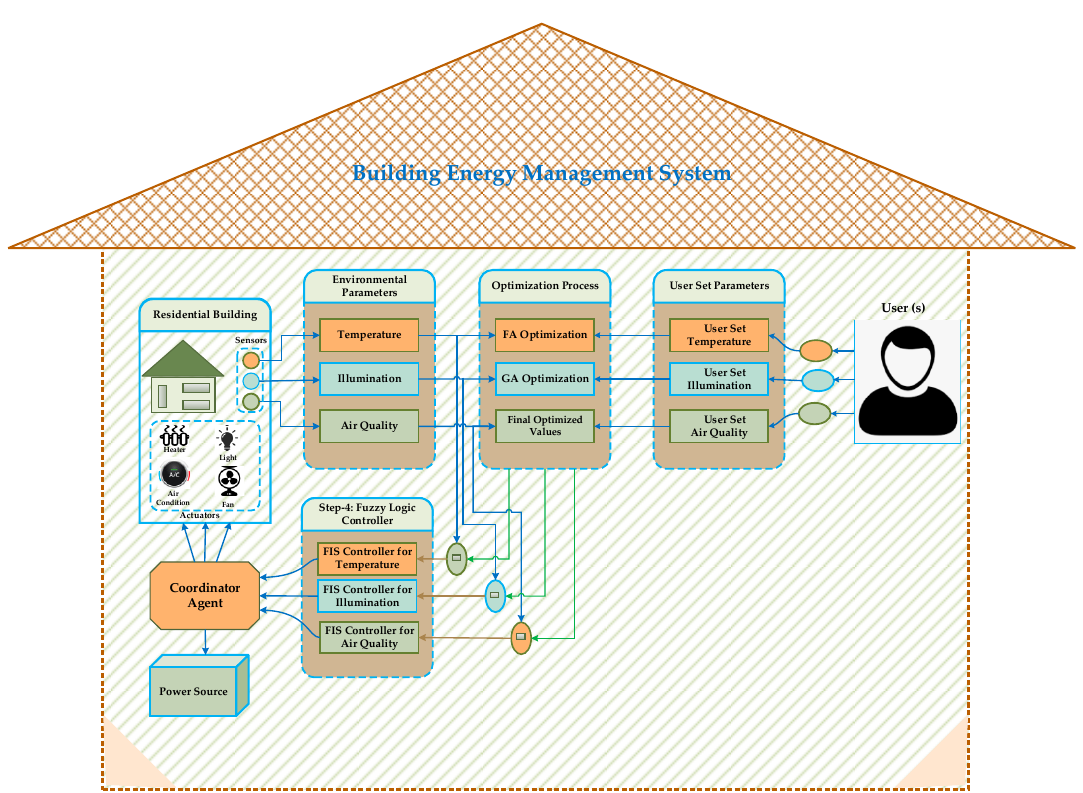
Figure 1. Proposed firefly algorithm-genetic algorithm (FA-GA) approach for energy management.